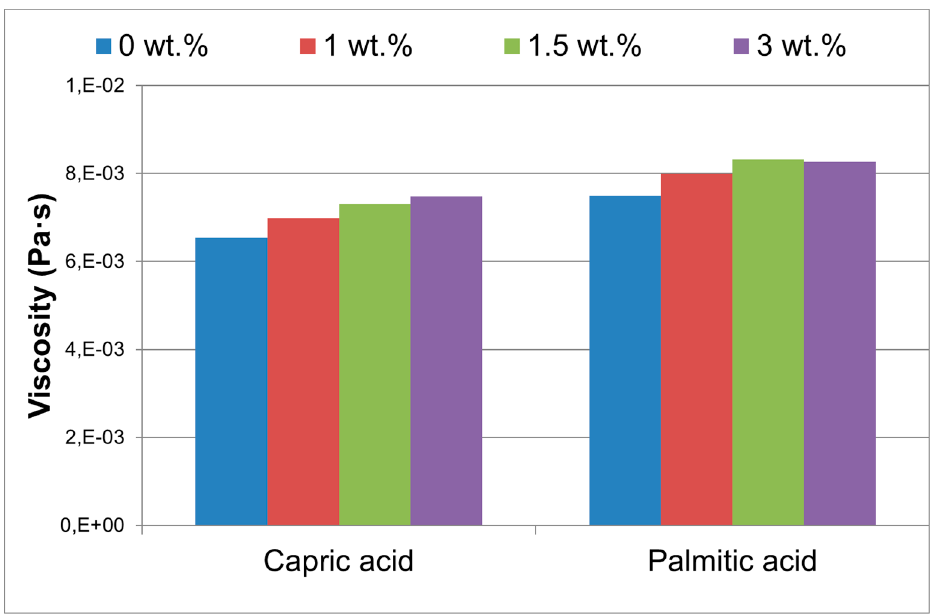
Figure 4. Viscosity of the NEPCM vs. the amount of CuO nanoparticles (wt.%).